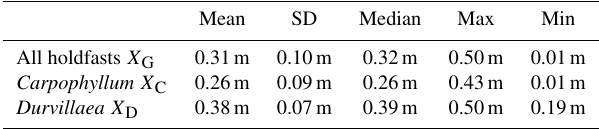
Table 3. Results for the calculation of the upper living- position X C / D / G relative to MLWS for holdfasts at the Kaik¯oura tide gauge. Note that only holdfasts of Carpophyllum and Durvil- laea in sheltered locations were used to calculate this elevation.